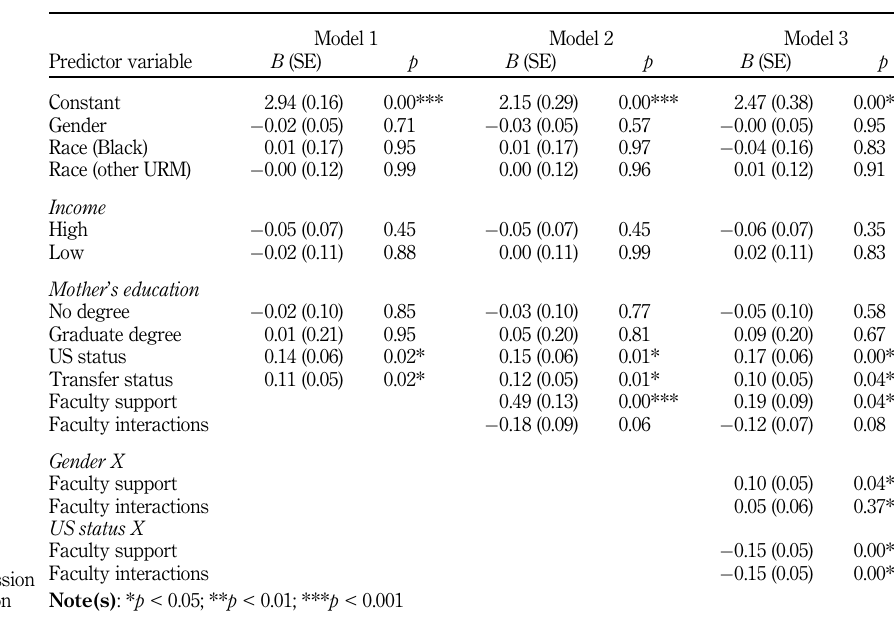
Table 5. Hierarchical regression models for